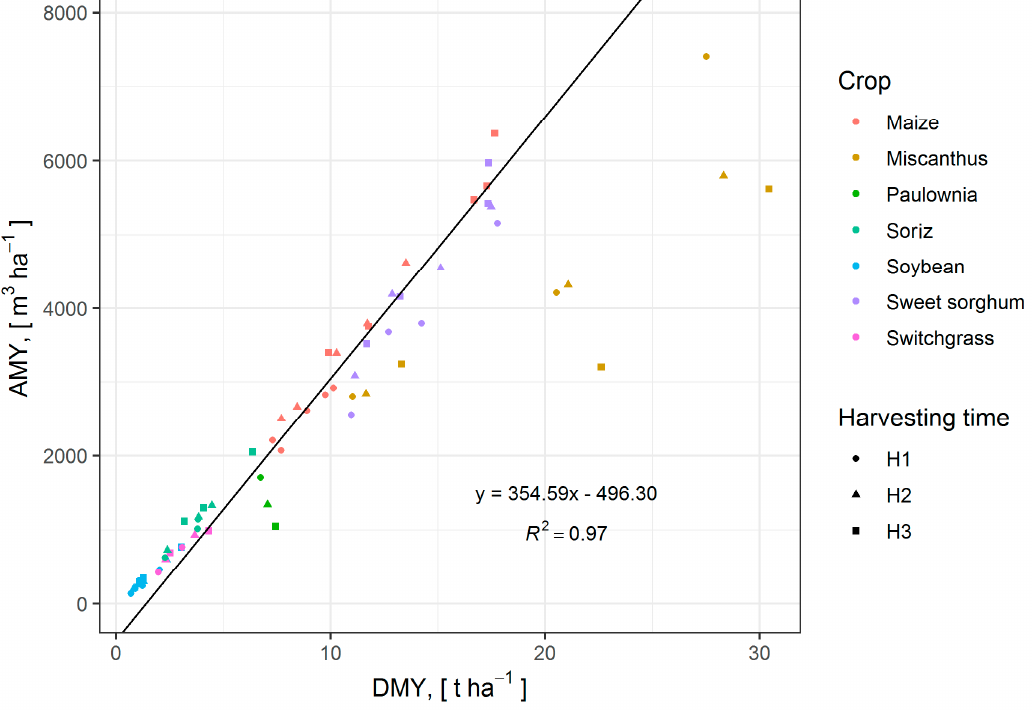
Figure 5. Correlation between dry matter yield (DMY) in t ha − 1 and areal methane yield (AMY) in m 3 ha − 1 for the total of 22 varieties from 7 crops harvested in three harvesting times (H1, H2 and H3) in 2017 (total amount of samples n = 66).